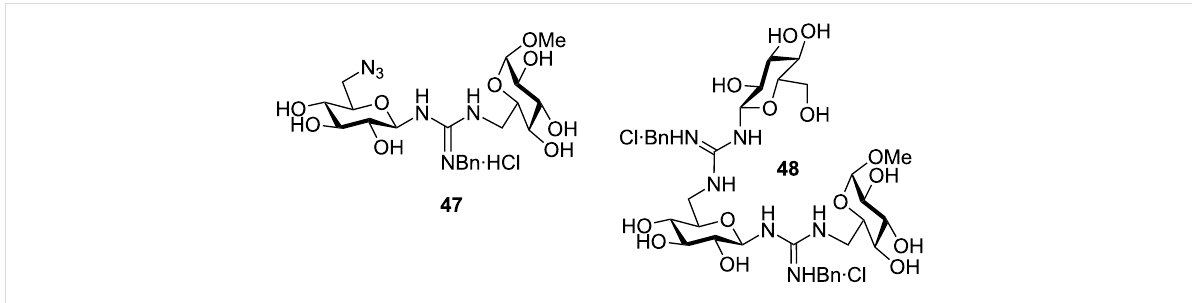
Figure 20: β (1 → 6)-Guanidine-linked pseudodi- and pseudotrisaccharides 47 and 48 .